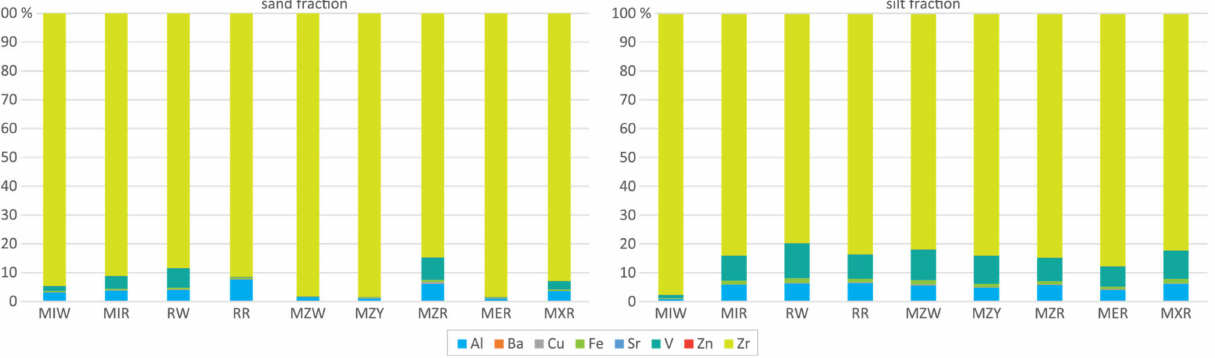
Figure 8. Individual variable relative contribution for the HI adjusted in the samples sand and silt fractions (in